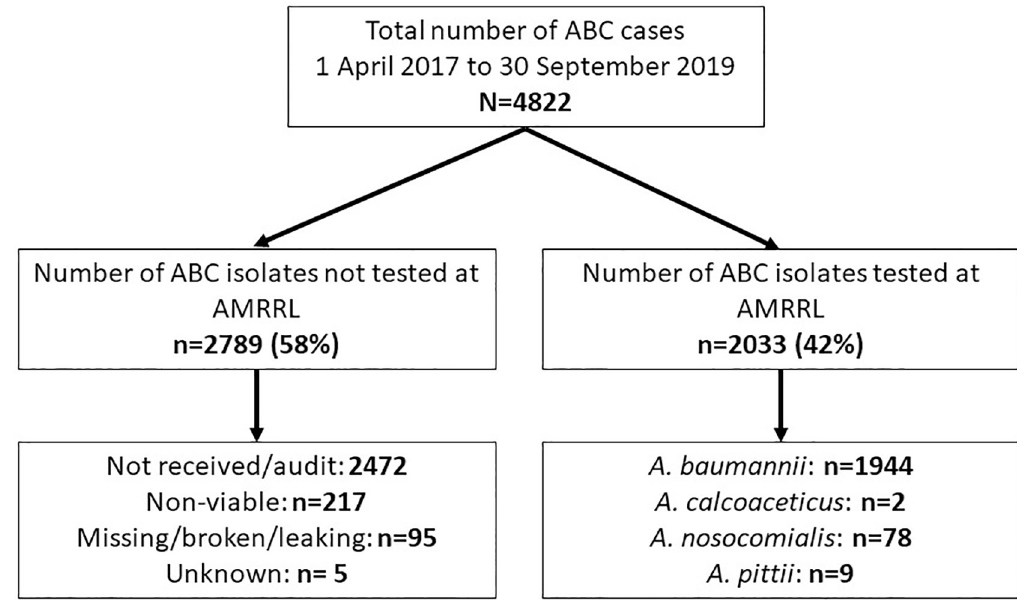
Fig 1. Cases of Acinetobacter baumannii complex (ABC) identified from South Africa from 1 April 2017 to 30 September 2019, N = 4822.